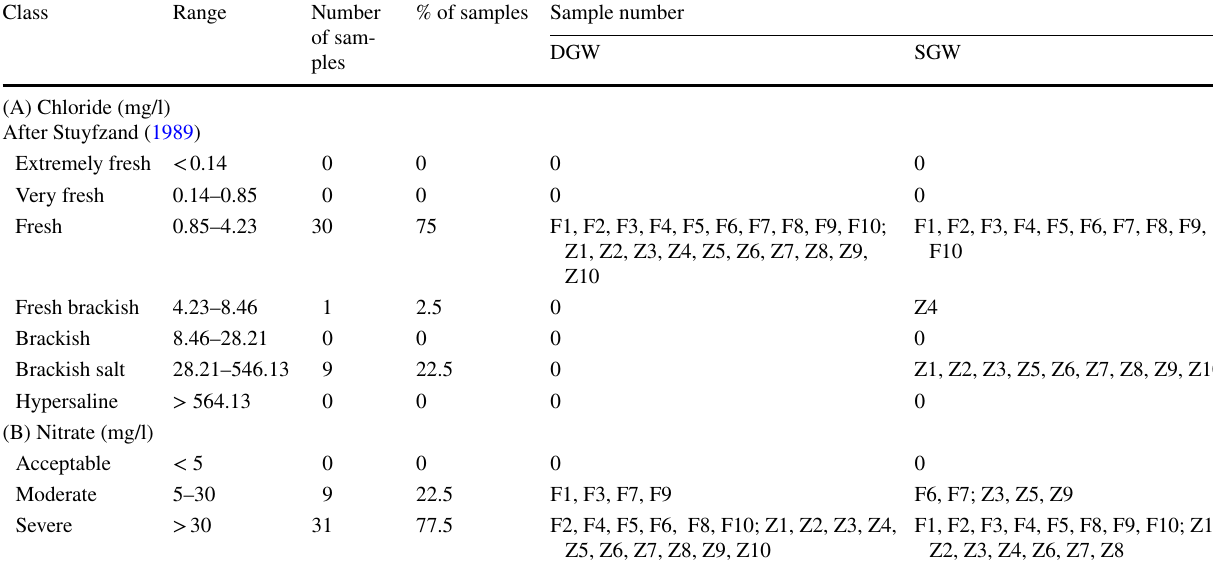
Table 6 Groundwater classification based on chloride and nitrate